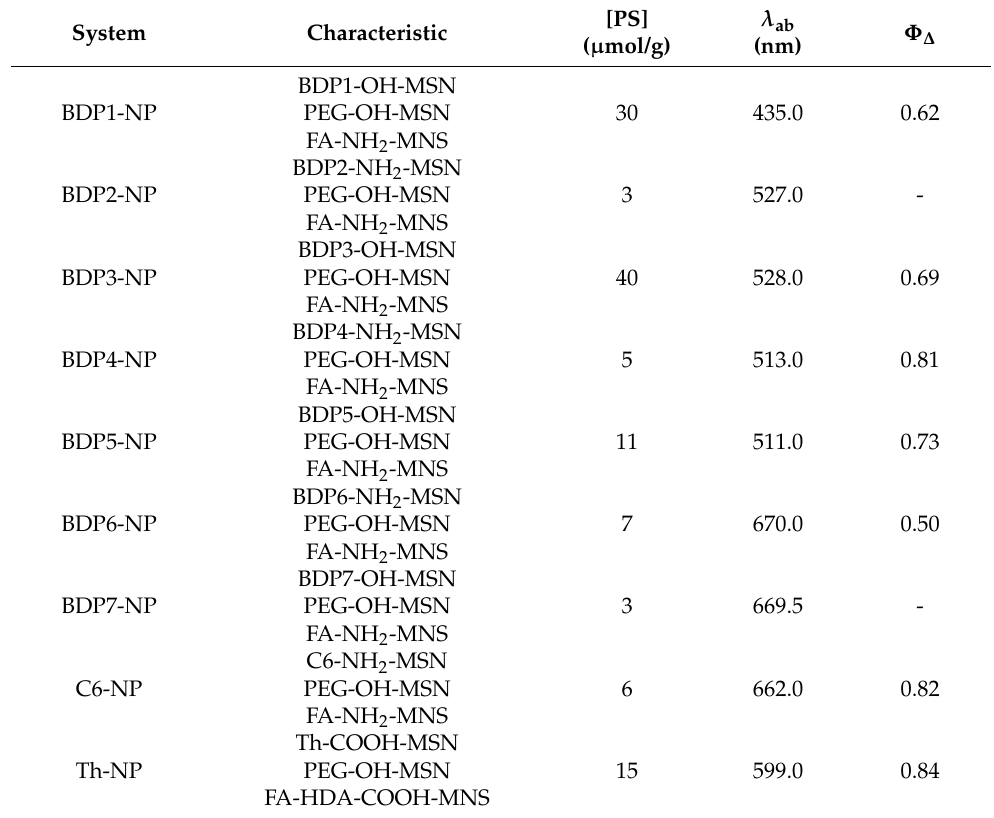
Table 3. Cargo of PS at MSNs, absorption maxima ( λ ab ) and the singlet oxygen quantum yield in CH 3 OD ( Φ ∆ ) measured after stirring the suspensions for 24 h of the PS-PEG-FA-MSN systems.